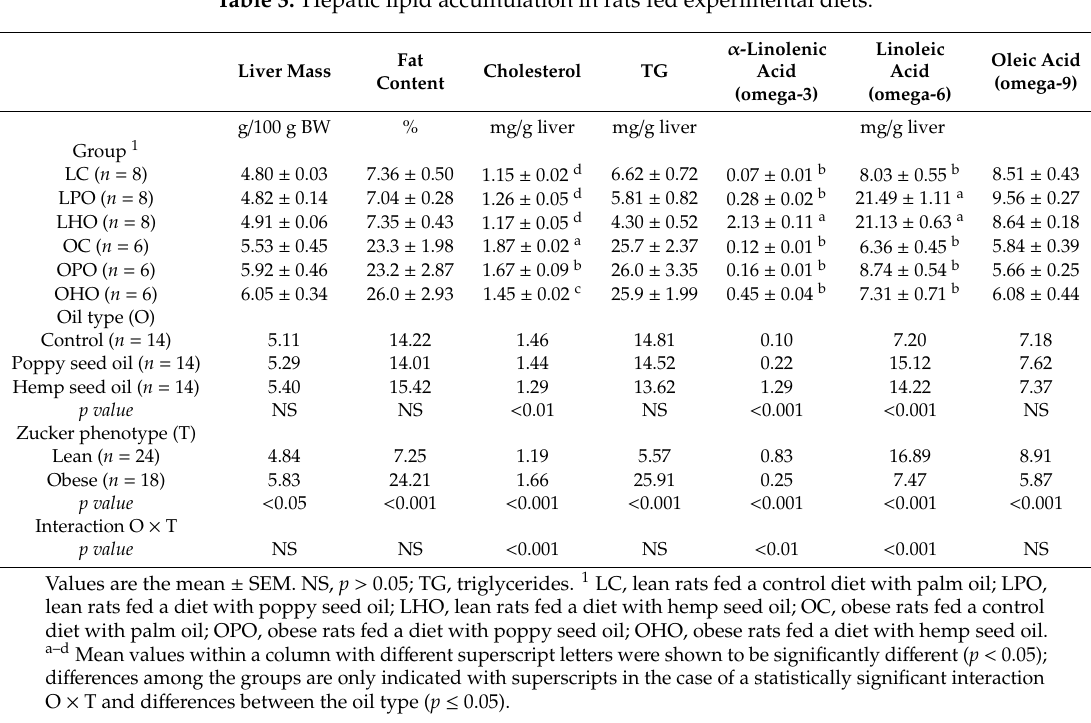
Table 3. Hepatic lipid accumulation in rats fed experimental diets.